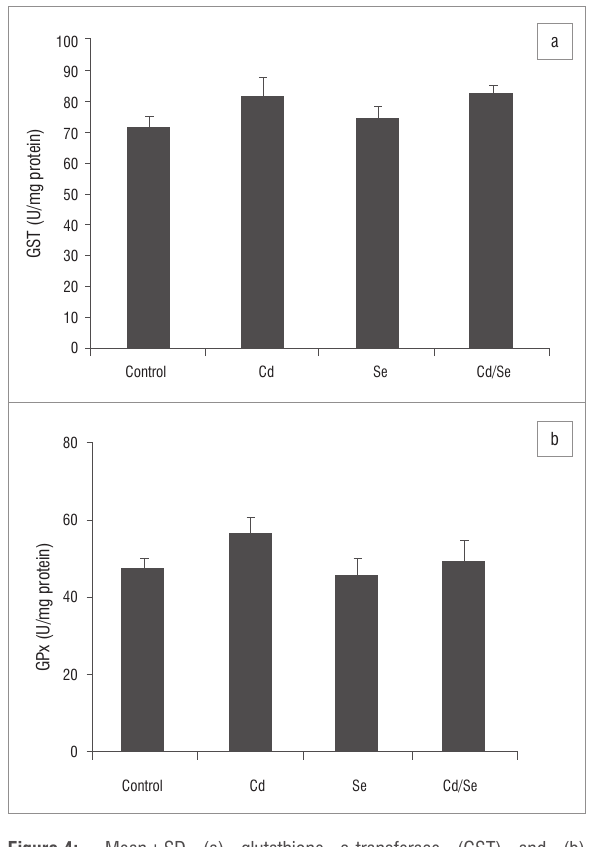
Figure 4: Mean±SD (a) glutathione s-transferase (GST) and (b) glutathione peroxidase (GPx) activities in the kidneys of male rats ( n =5) that received cadmium (1.67 mg/kg cadmium chloride in saline), selenium (0.23 mg/kg sodium selenite solution), cadmium and selenium (Cd/Se; 1.67 mg/kg cadmium chloride in saline and 0.23 mg/kg sodium selenite solution) or saline (control) daily (IP) for 15 days. *Statistically significantly different from control at p<0.05.